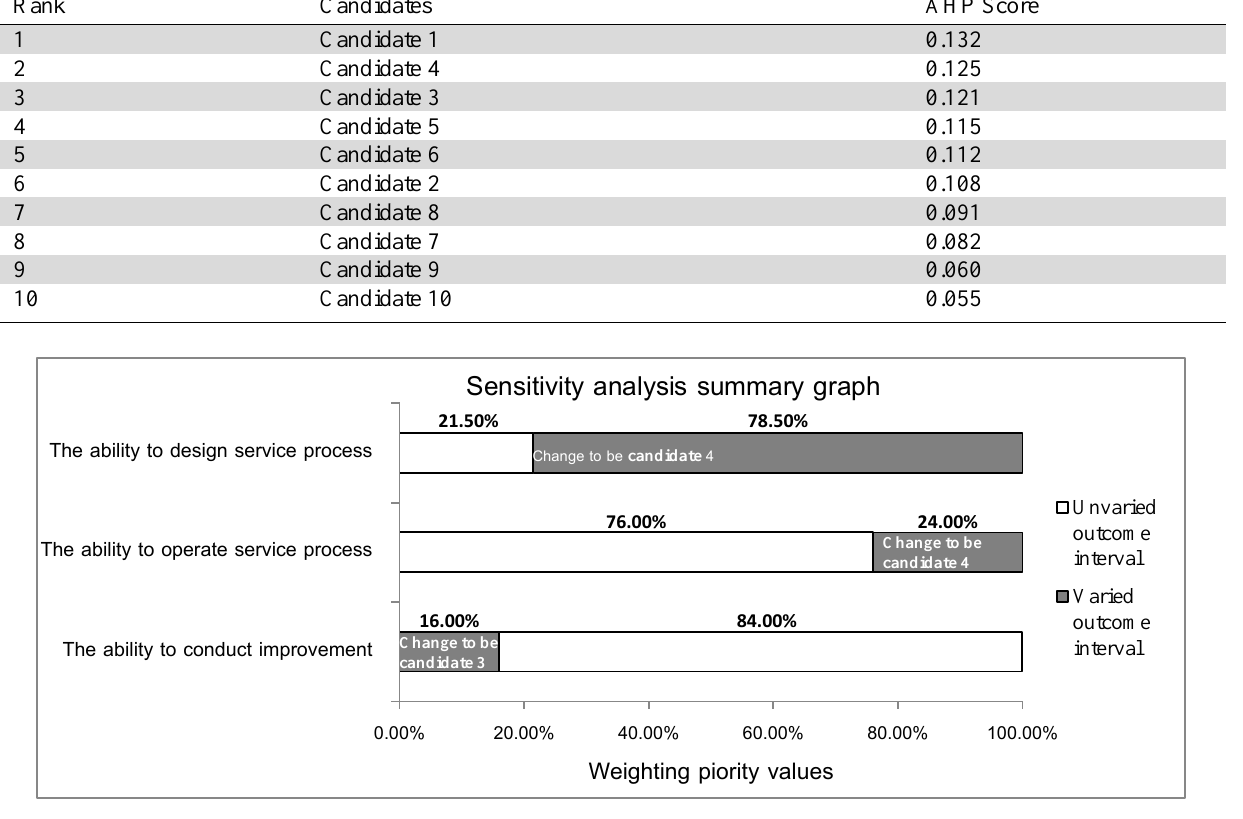
Fig. 6. Sensitivity analysis summary